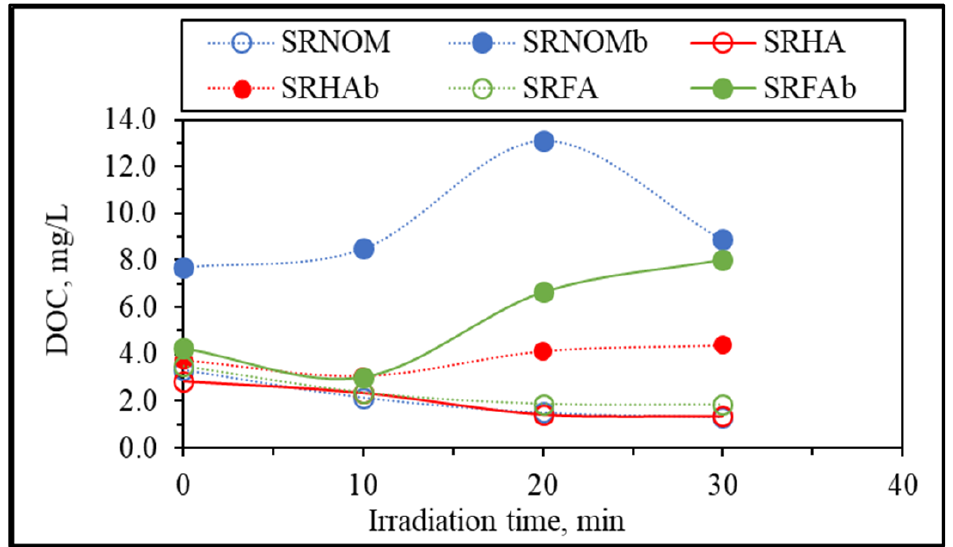
Figure 5. Irradiation-time-dependent DOC content of the organic matrix of samples upon solar photocatalytic degradation in the absence/presence of E. coli (b denotes the presence of bacteria).